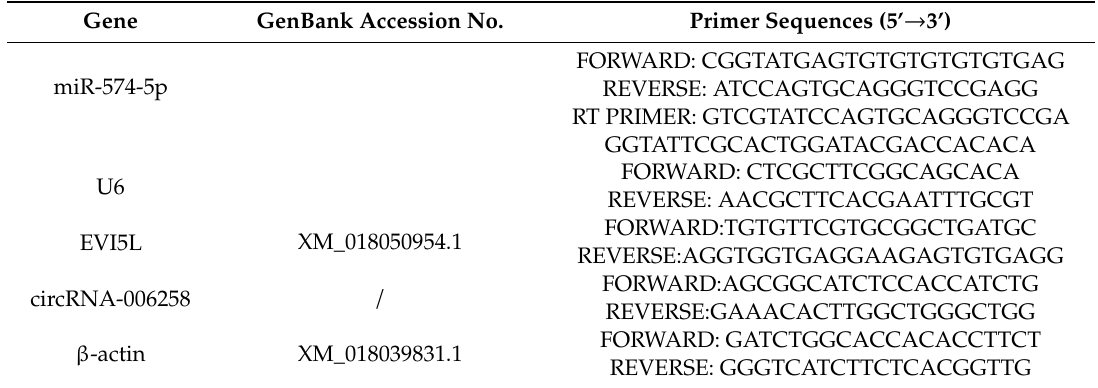
Table 1. Primer information for RT-qPCR.